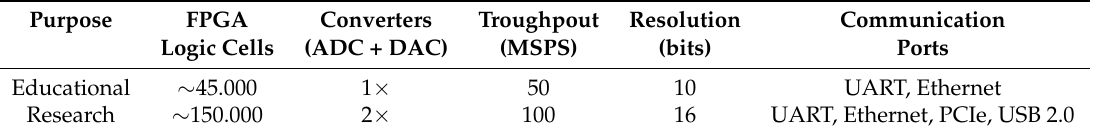
Table 1. Requirements of the platform for different